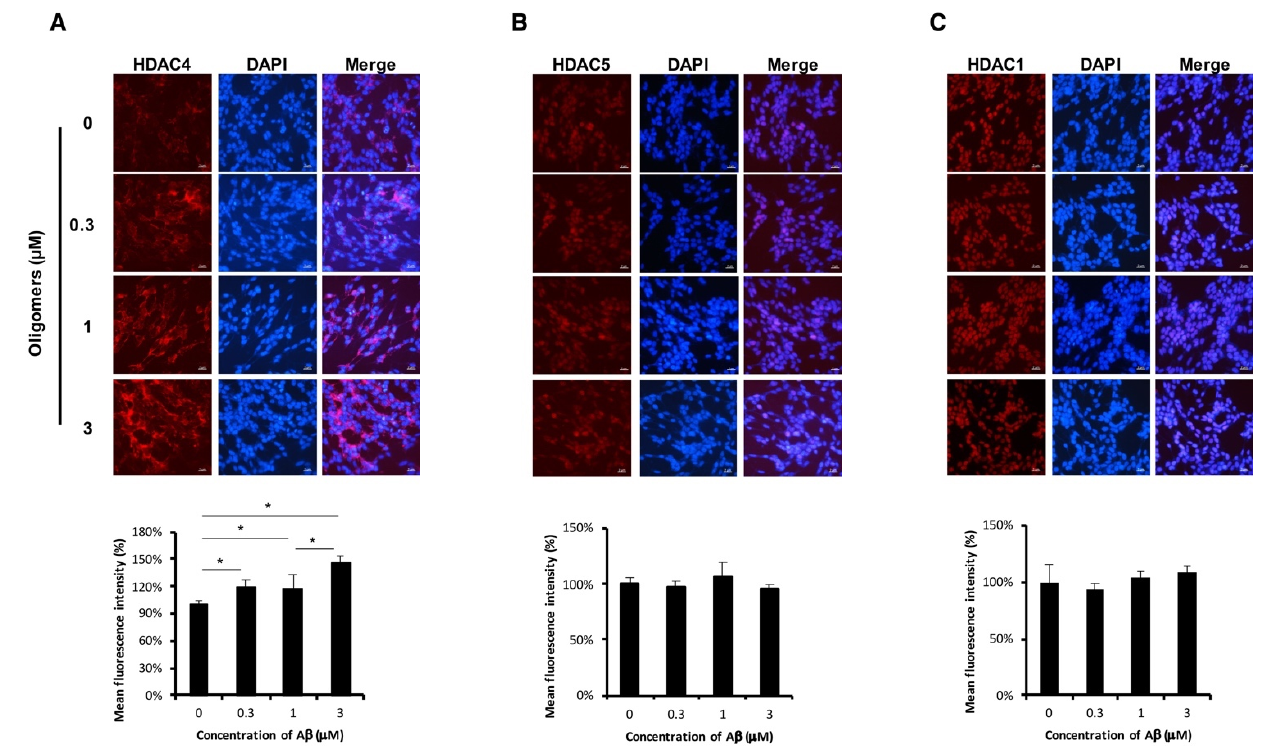
Figure 1. Representative images of ( A ) HDAC4, ( B ) HDAC5, and ( C ) HDAC1 expression in the neuroblastoma cell line SH-SY5Y after 48 h of exposure to an increasing concentration of A β oligomers. Scale bar, 2 µ m. Bottom graphs depict the quantification of immunofluorescent intensity of target proteins in A β oligomers-treated cells, relative to the untreated control. Data are mean ± SEM. One-way ANOVA was used (F = 9.54, p = 0.0021. * p < 0.05 by Tukey’s post hoc test).